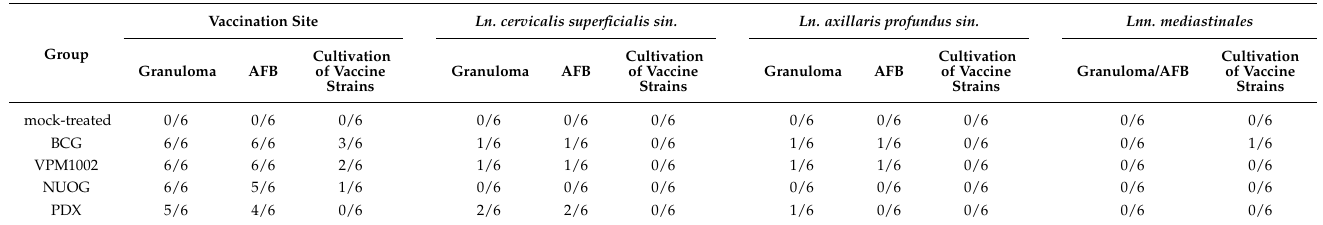
Table 2. Detection of granulomas, re-isolation of vaccine strains, and detection of acid-fast bacteria (AFB) by Ziehl–Neelsen staining from goats vaccinated with either BCG, VPM1002, NUOG, PDX, or mock-treated. Tissues, including the site of vaccination, Lymphonodus (Ln.) cervicalis superficialis sinister (sin.) , Ln. axillaris profundus sin. , and Lymphonodi (Lnn.) mediastinales , were obtained at necropsy 127 dpv. NumberofPositiveGoats/NumberofGoatsPerGroup VaccinationSite Ln. cervicalissuperficialissin. Ln. axillarisprofundussin. Lnn. Group